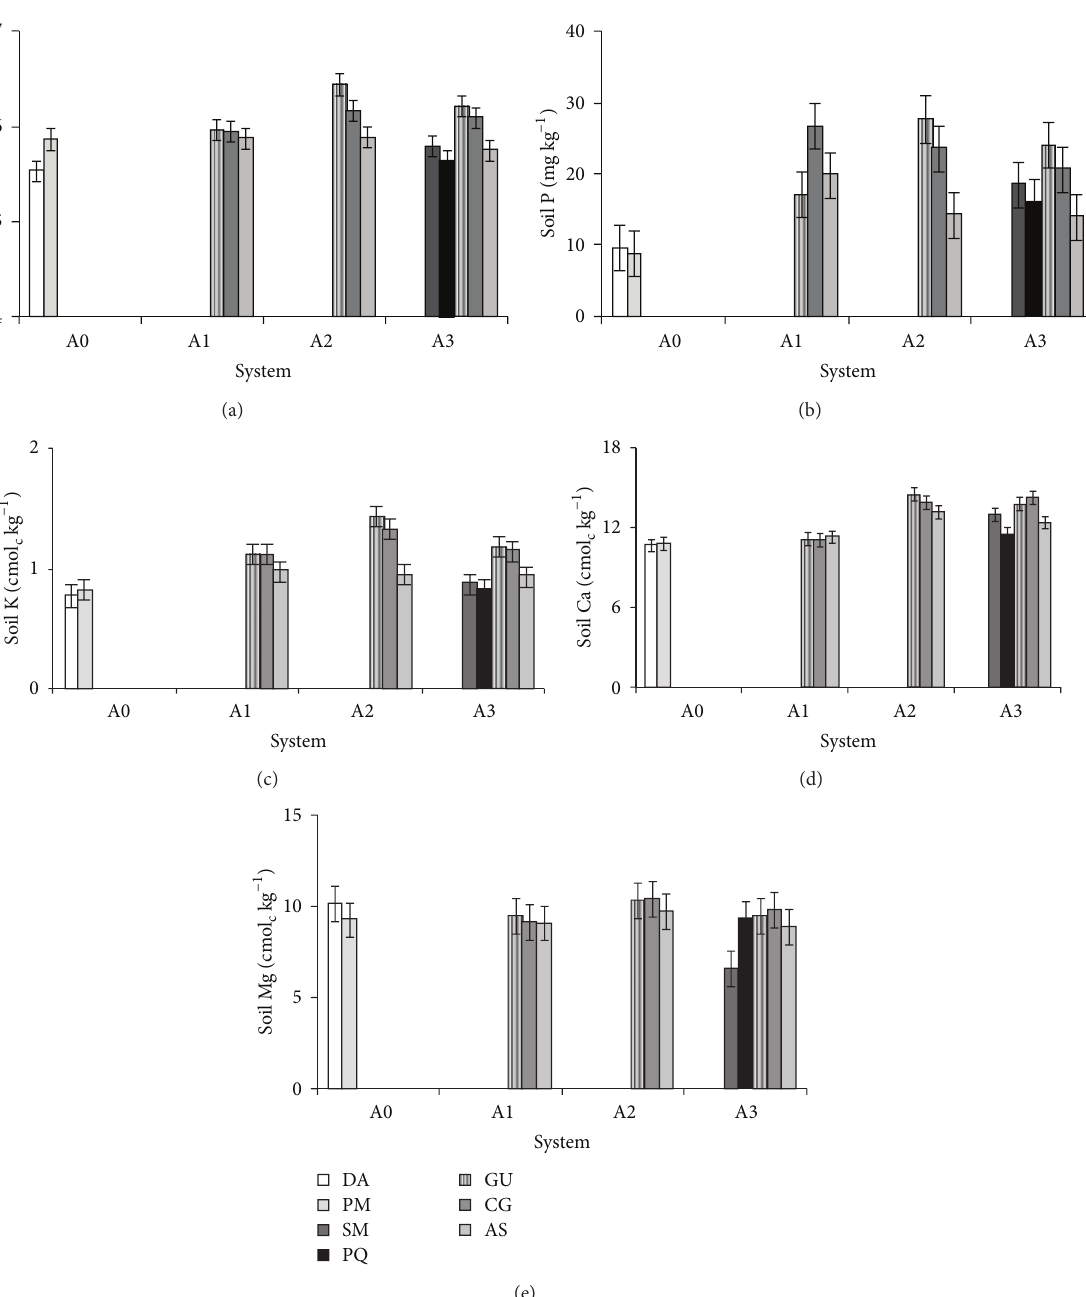
Figure 1: Soil fertility parameters associated with pastures and tree species in multistrata silvopastoral systems in the Sinu Valley, Colombia. Abbreviations: D. aristatum (DA); P. maximum (PM); G. ulmifolia (GU); C. grandis (CG); A. saman (AS); P. quinata (PQ); S. macrophylla